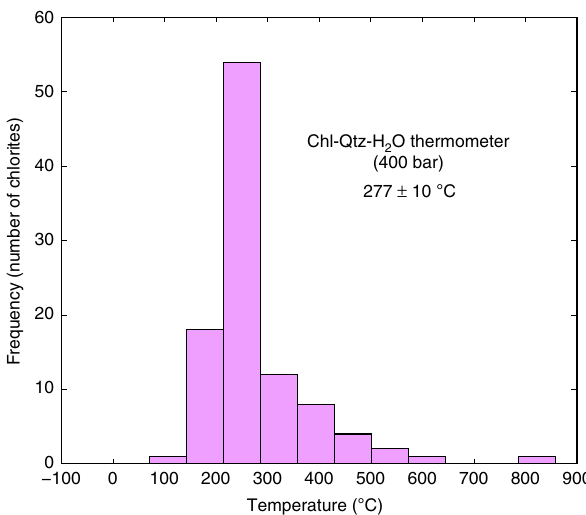
Fig. 4 Calculated temperature for the hydrothermal event. Bootstrap statistical analysis 40 on chlorite temperatures calculated at 400 bar using the Chlorite-Qtz-H 2 O thermometer 36